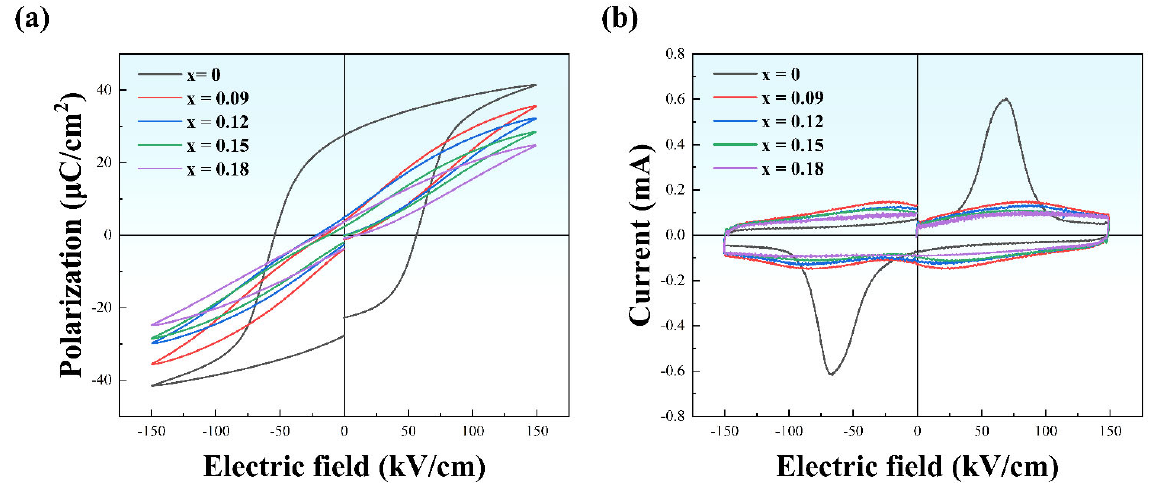
Figure 4. ( a ) Bipolar P-E loops and ( b ) bipolar I-E loops under 150 kV/cm at 100 Hz for various compositions of NBT-SBT-xBMZ ceramics (x = 0, 0.09, 0.12, 0.15, 0.18).